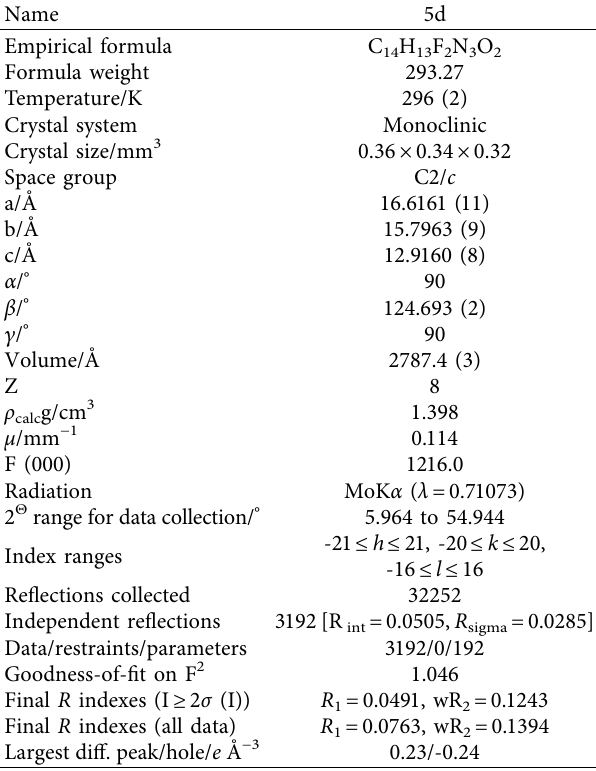
Table 1: Crystal data of compound 5d